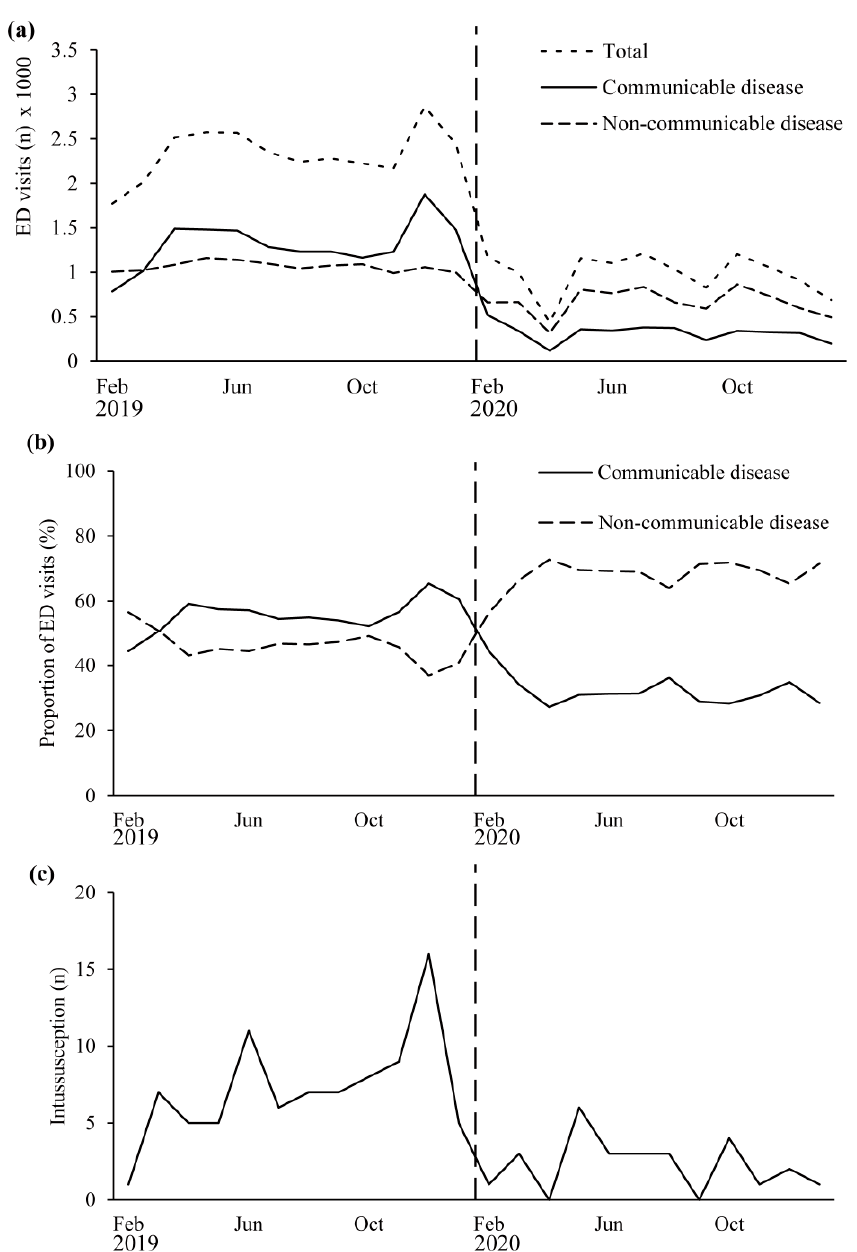
Figure 1. Monthly emergency department (ED) visits and number of children aged ≤ 7 years with communicable diseases, non-communicable diseases, and intussusception during the year before and the year after the outbreak of coronavirus disease 2019 (COVID-19). ( a ) Monthly ED visits during the overall study period. ( b ) Monthly proportion of communicable and non-communicable diseases over total ED visits. ( c ) Monthly number of patients with intussusception. Vertical dotted line: COVID-19 outbreak and social lockdown.